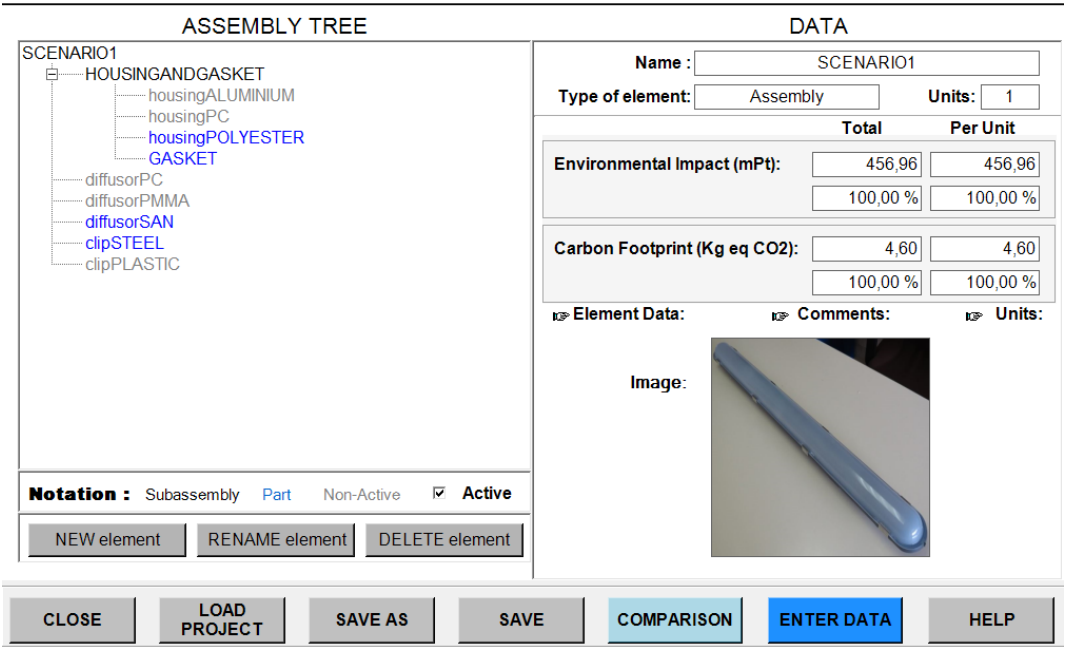
Figure 5. Results for Scenario 1.